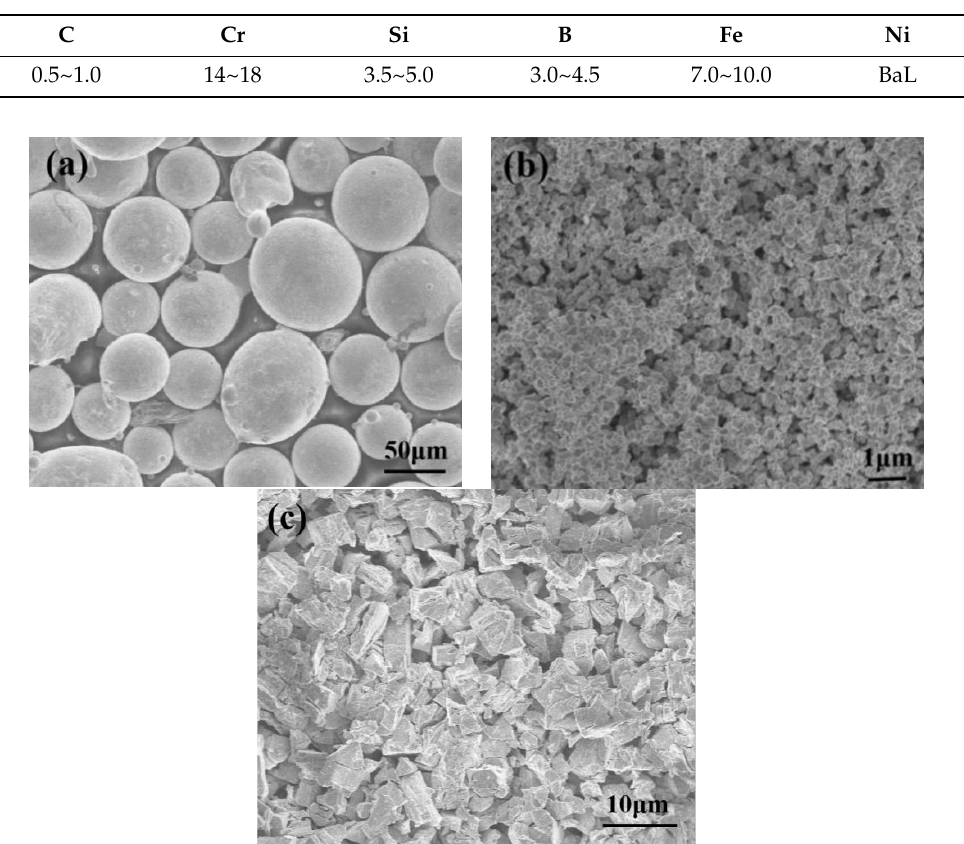
Table 3. Cladding material ratio (wt. %).